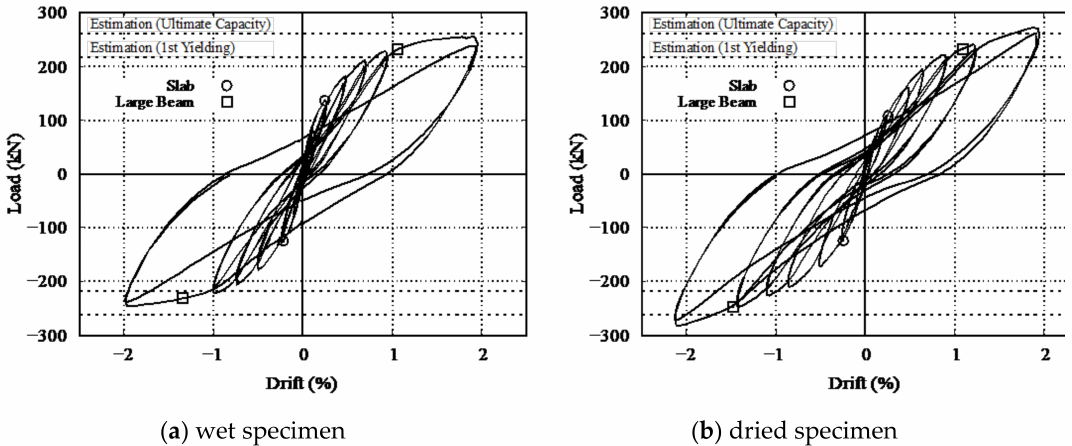
Figure 10. Load–drift relationships. ( a ) Wet specimen, ( b ) dried specimen. Figure 11 compares the skeleton curves of the specimens with first and full (all rebar) yielding of the reinforcement of the large beams (LB), sub-beams (SB), and slabs. The two dashed lines represent the estimated tri-linear load–drift relationship of the beam–slab members (Figure 11) based on Architectural Institute of Japan (AIJ) and American Concrete Institute (ACI) standards as shown in Figure 12. The initial lateral structural stiffness K 0 , crack capacity V cr , yield capacity V y , and effective yield stiffness K y are given as follows.